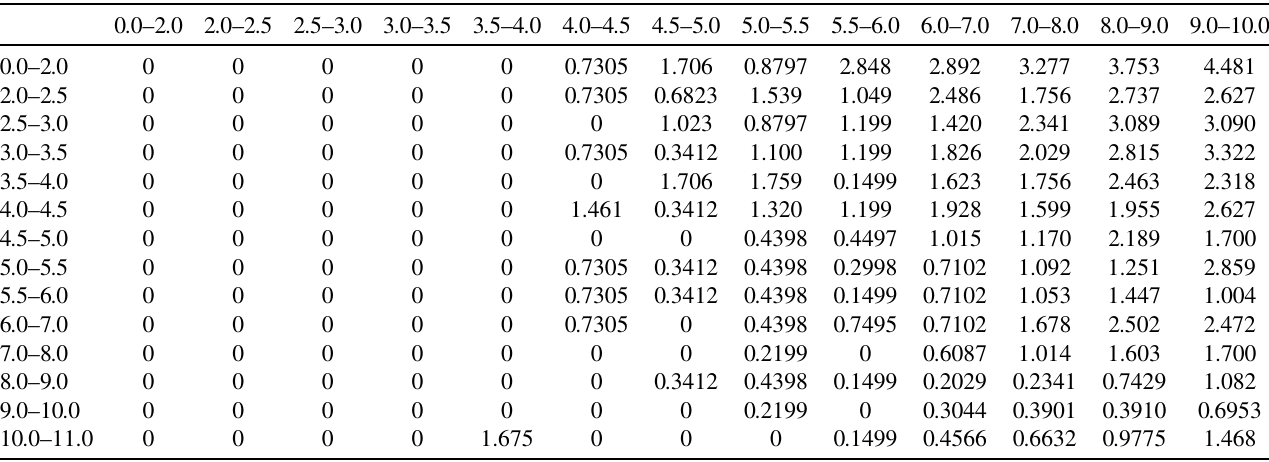
TABLE XII. (cid:4) þ background from (cid:3) (cid:5) CC events (all values (cid:2) 10 (cid:1) 4